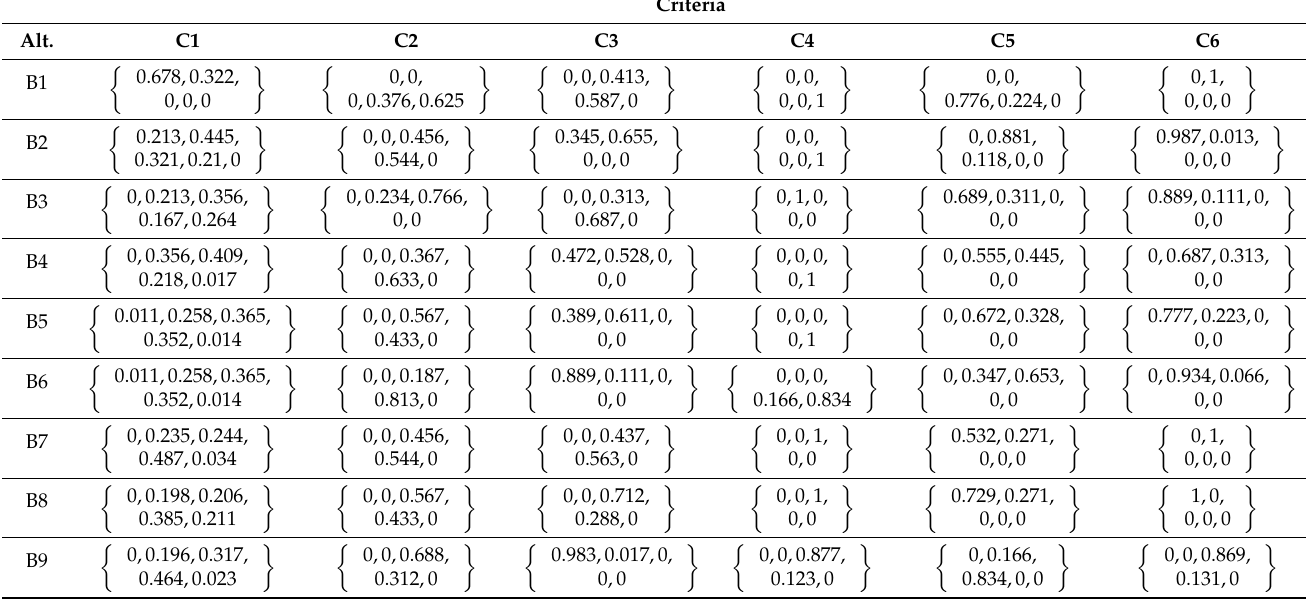
After each group has defined evaluation ratings of the bridges, the aggregated values are calculated for each rating according to each criterion, using expressions (25) and (26). Each group is equally important, and the weights are defined as: W D = aggregated values are presented in Table 5. Table 5. Aggregated belief decision matrix of the alternatives assessments given by all groups.